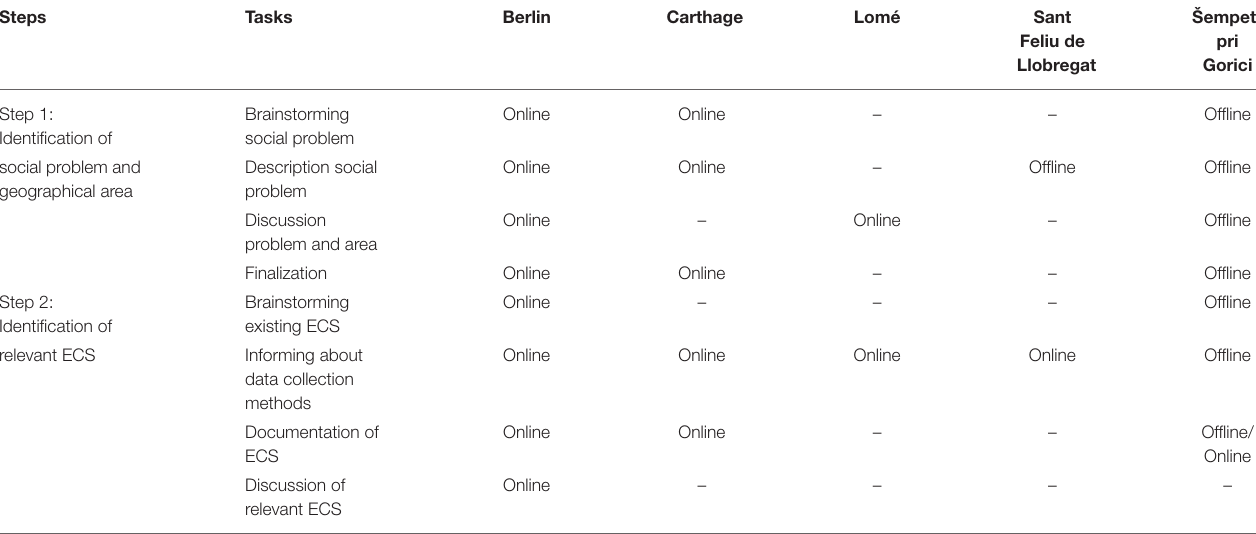
TABLE 6 | Evaluation planning